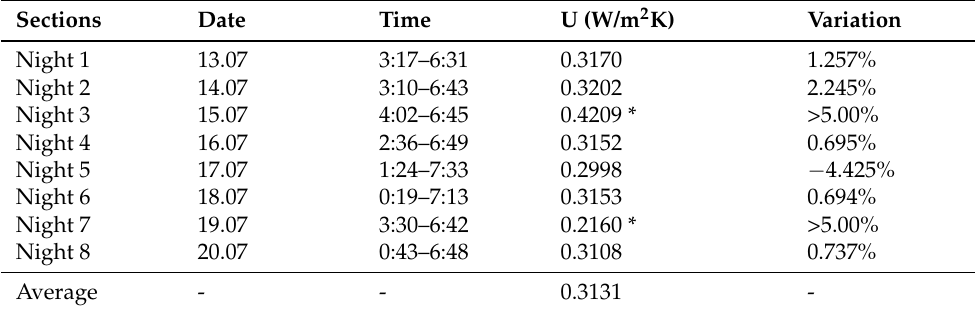
Figure 16. Evaluation of the U-value of a double-glazed insulated glass window for six days. Table 5. Average U-value by